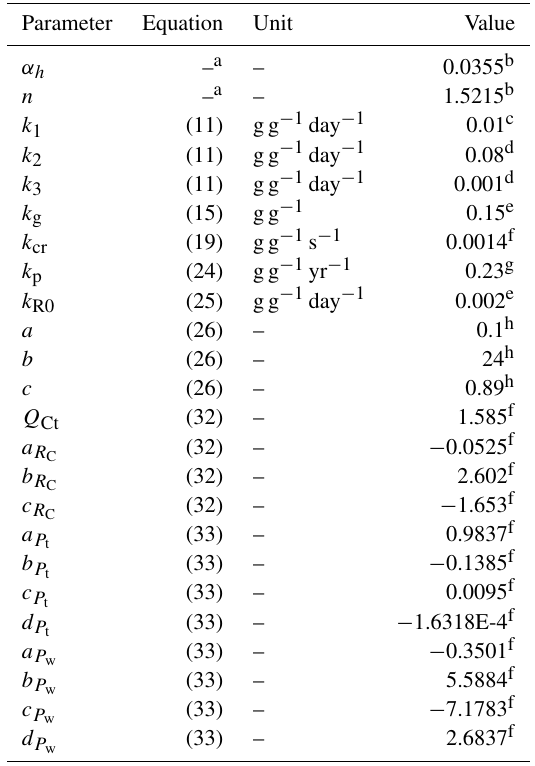
Table 2. Parameters for soil water retention and C